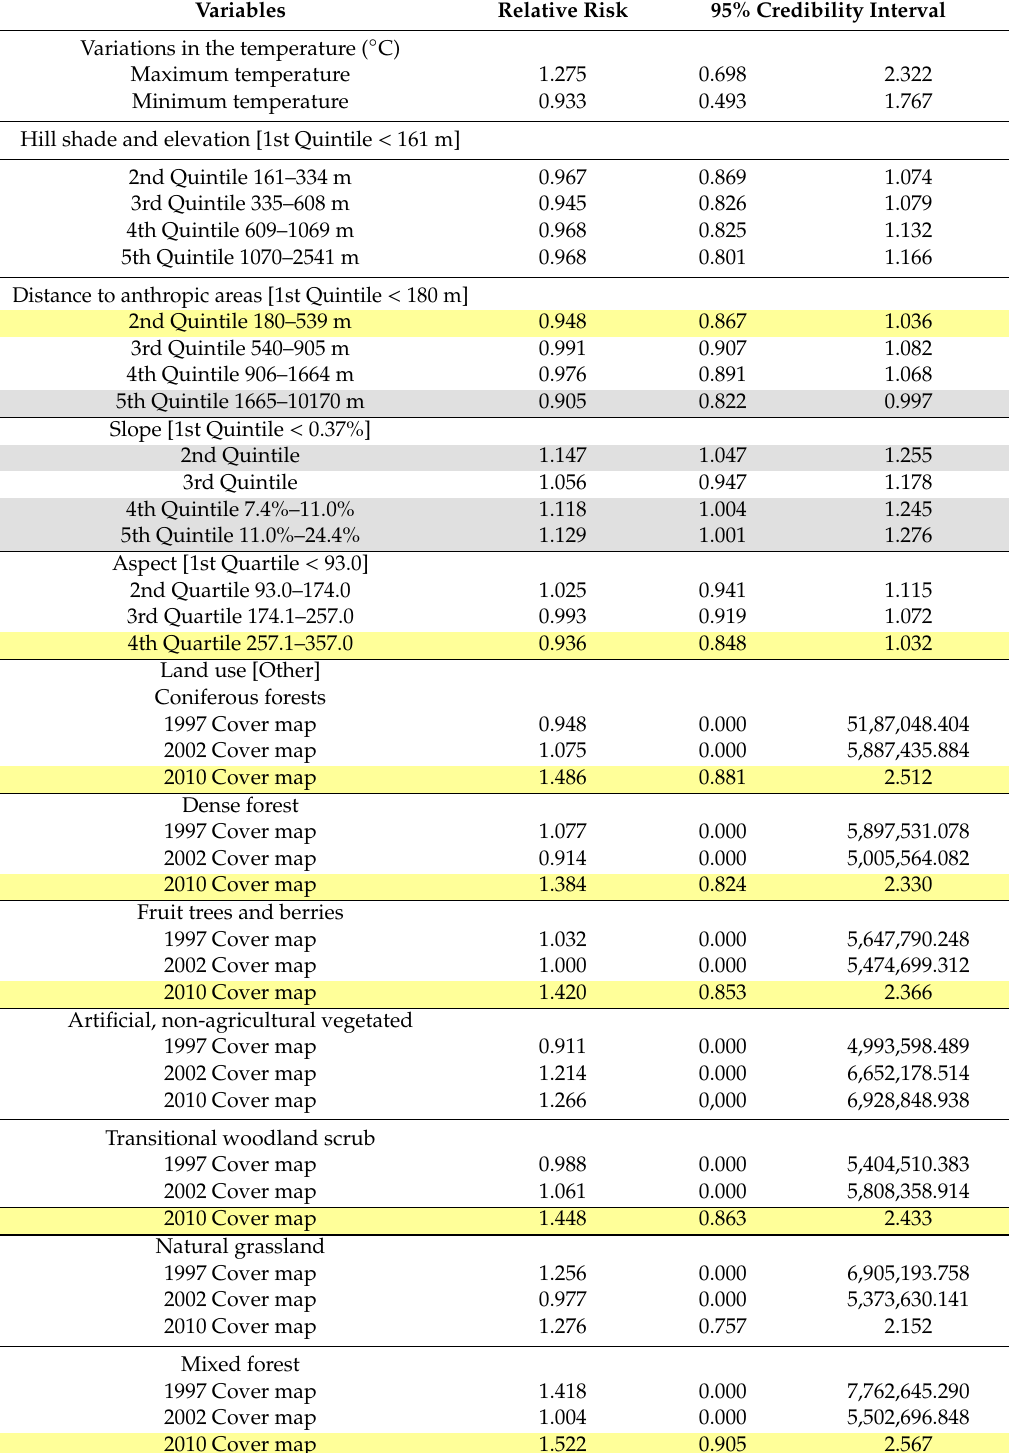
[Reference category between brackets]. Shaded in grey 95% Credibility interval did not contain 1, shaded in yellow 90% Credibility interval did not contain